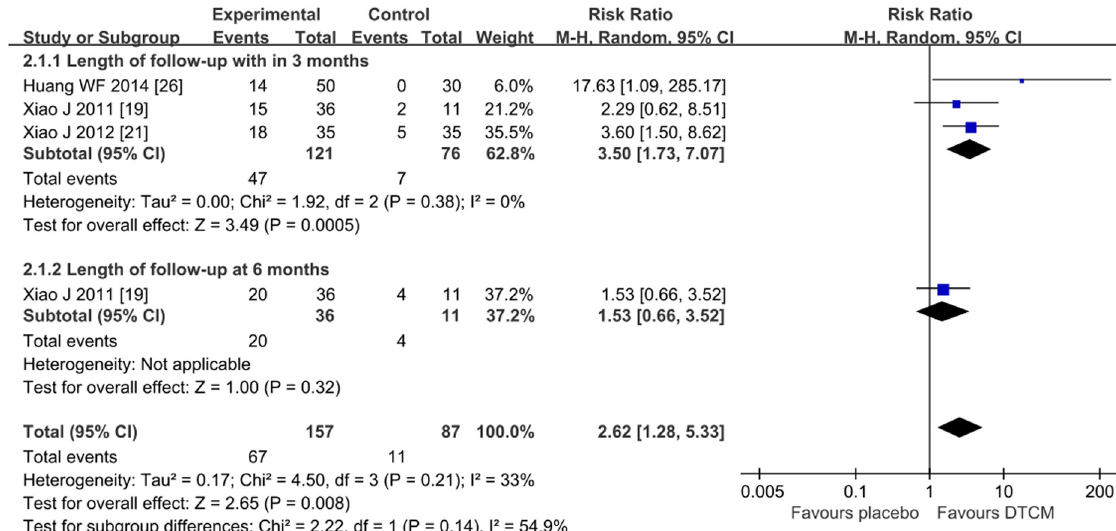
Fig 4. Analysis 2.1 Forest plot of comparison: DTCM treatment alone compared with placebo. Outcome 2.1: Rate of hr-HPV clearance.